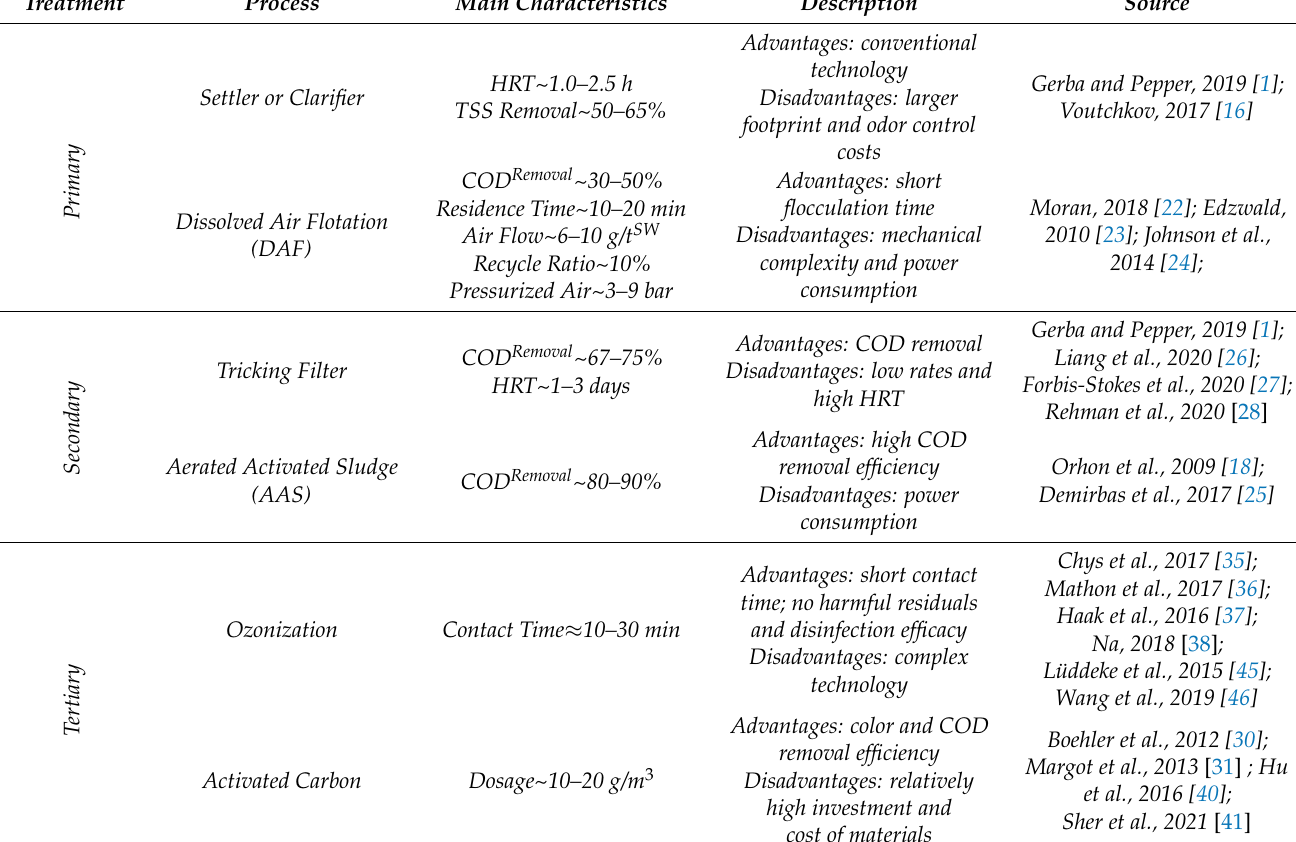
Table 2. Typical Sewage-Water Treatment